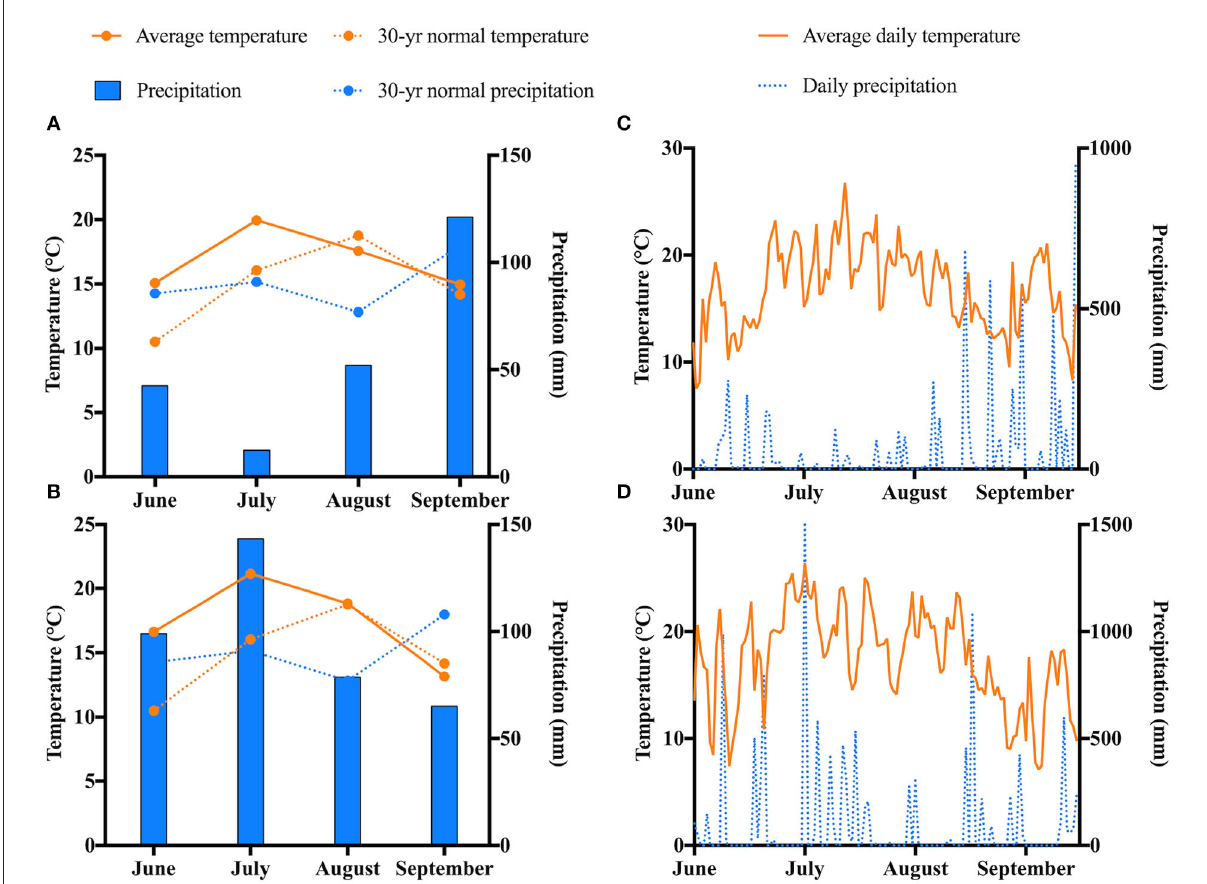
FIGURE2 Weather trends at the experimental site in Chatham, MI for the duration of the study. Monthly weather in (A) 2019 and (B) 2020. Daily weather in (C) 2019 and (D)